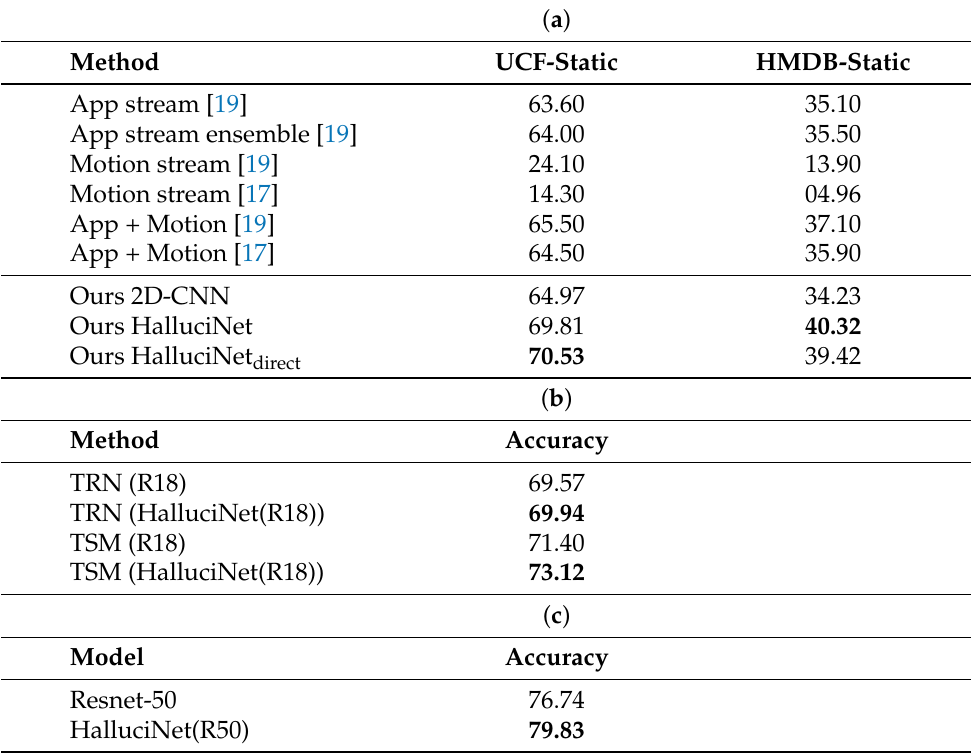
Table 1. ( a ) Action recognition results and comparison. ( b ) HalluciNet helps recent developments, such as TRN and TSM. ( c ) Multiframe inference on better base model. ( b , c ) Evaluated on UCF101. ( a